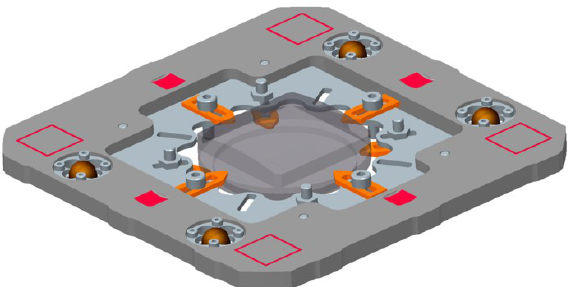
Fig. 2 Measurement equipment – CAD design. Red are the surfaces for alignment in different measurement machines. Dark yellow are the Rubin spheres. In the middle there is the inlay with a demonstrator optics for the project.